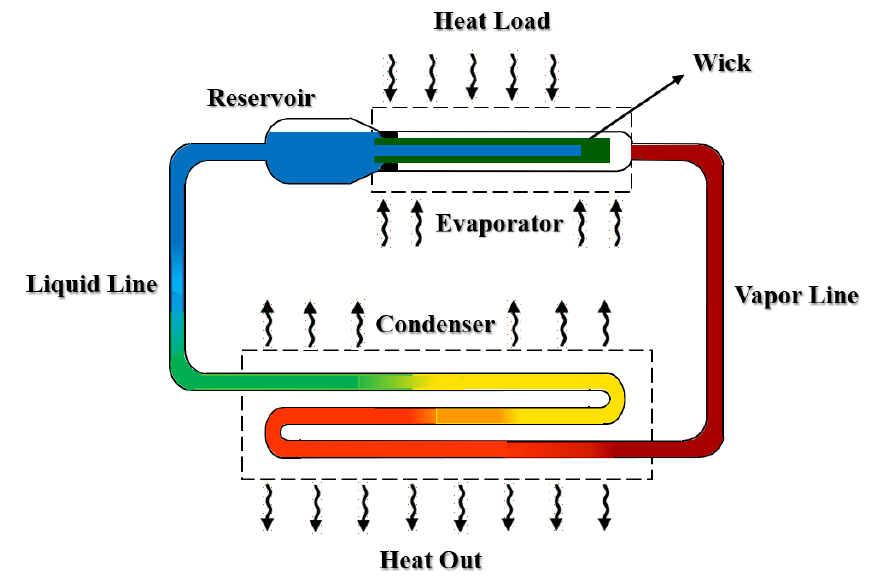
Figure 3. Principal geometry scheme of an LHP in components detail.